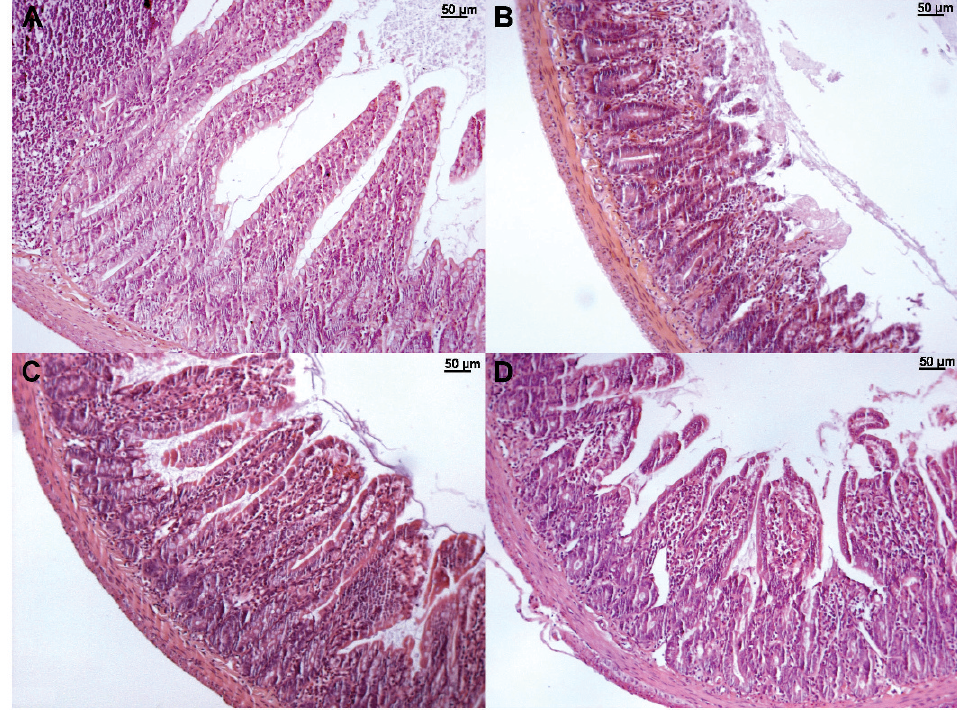
Figure 3 - Representative photomicrographs of the small bowel (HE, x100) from the control (A), IR (B), LIPC (C), and RIPC (D) groups. Normal small intestine architecture is shown in the control group (A). The IR group (B) demonstrates a marked loss of villus height, while the LIPC (C) and RIPC (D) groups have less